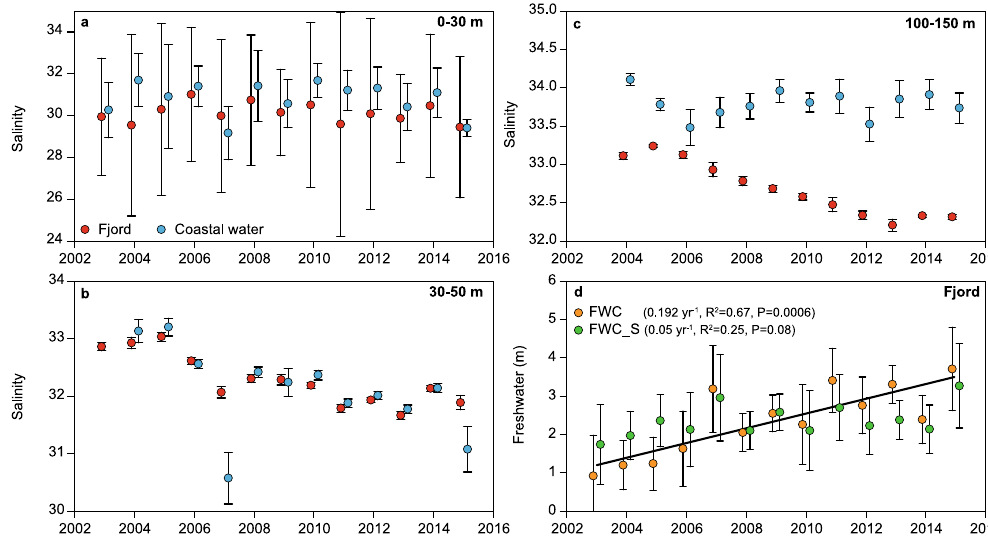
Figure 3. Changes in summer salinity of fjord and coastal waters at the study site in East Greenland for different depth strata: ( a ) 0–30 m; ( b ) 30–50 m and ( c ) 100–150 m. ( d ) Integrated estimate of freshwater content (FWC) in the top 50 m of the water column in the fjord. See text for definitions of FWC and FWC_S. The solid line represents the linear regression of